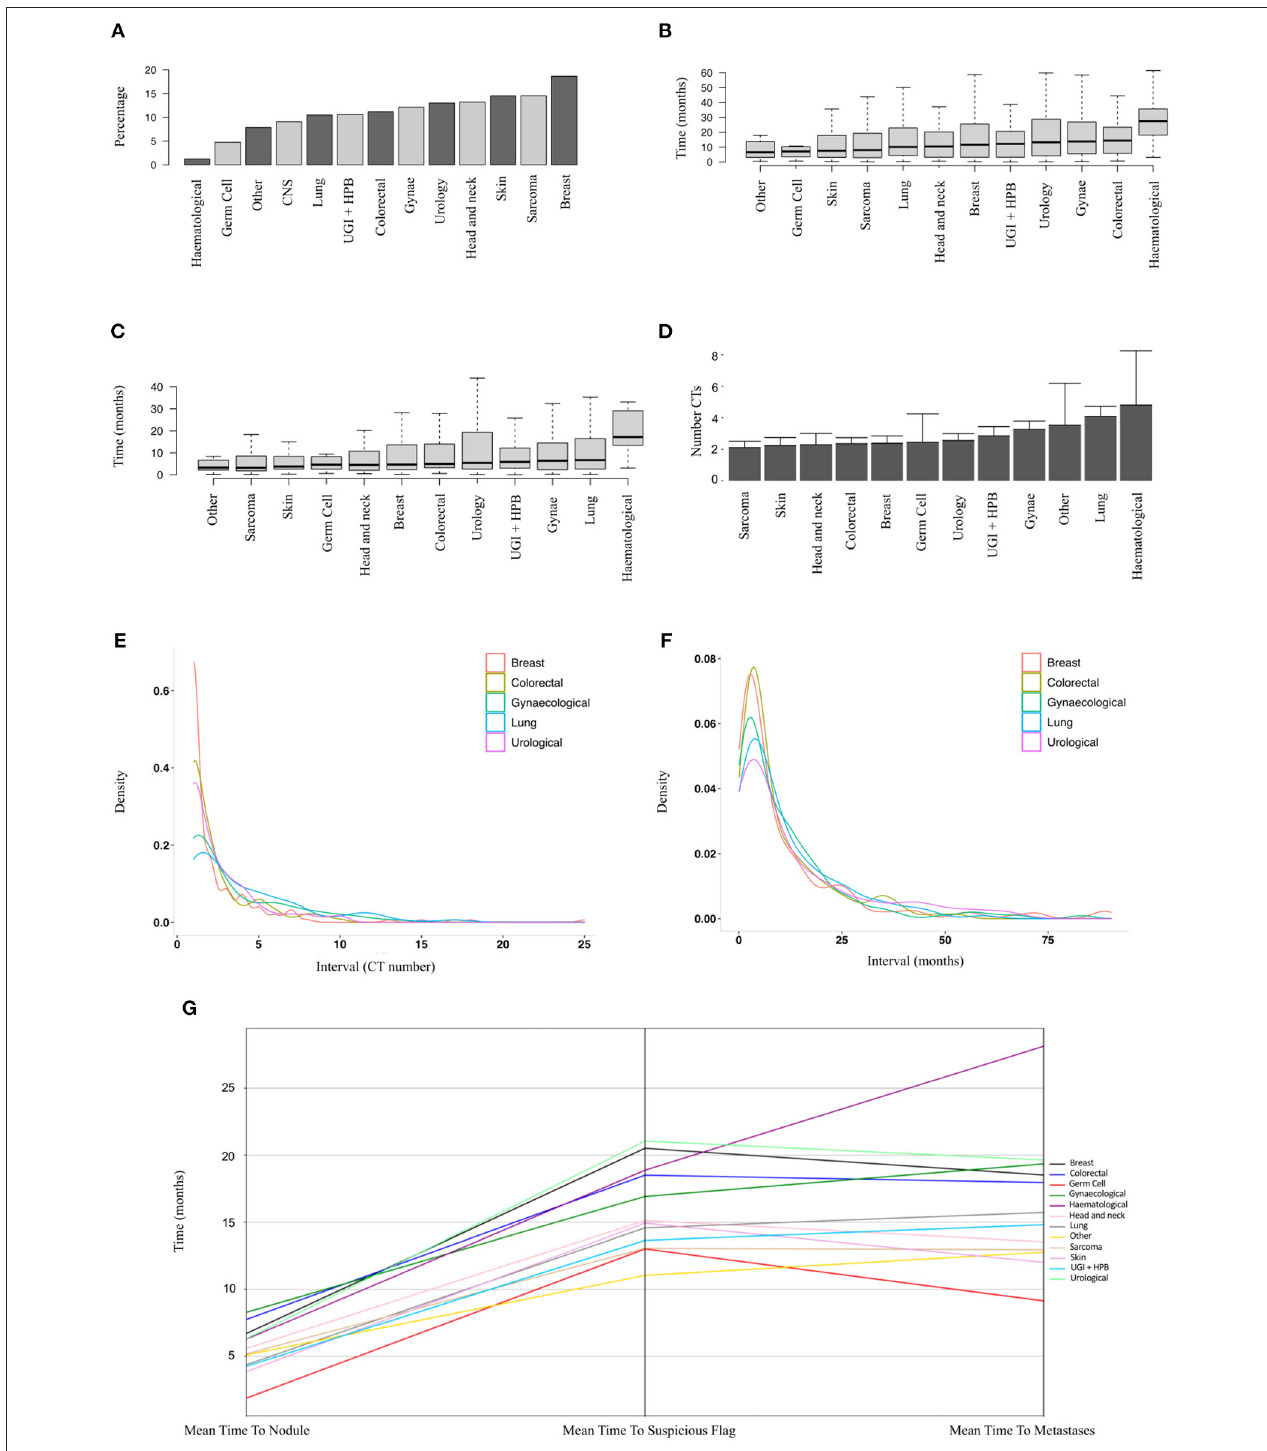
FIGURE 3 | Sub-group analysis of patients developing metastatic disease after a nodule diagnosis. (A) Proportions of patients developing metastatic disease by tumour group (9,077 patients, ranked by median). (B) Time to earliest metastasis in months from study inclusion by disease group (1,019 patients, ranked by median). (C) Time to earliest metastasis in months from lung nodule by disease group (1,019 patients, ranked by median). (D) Mean number of CT scans (with upper 95% CIs) between nodule diagnosis and metastases by tumour group (1,019 patients, ranked by mean). (E,F) Frequency density plots showing the number of CTs and time in months, respectively, between nodule diagnosis and metastasis by disease group (5 groups of 1,019 patients shown). (G) Parallel coordinates plot showing the mean time in months to lung nodule, suspicious flag (as assigned by the linear-SVM machine-learning model) or metastasis by disease group (1,019 patients).